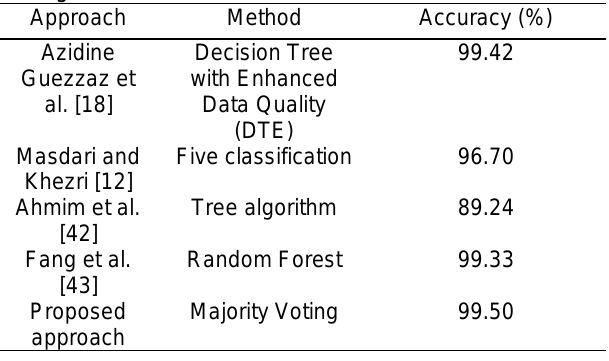
Table 12. Comparison of our approach using Majority Voting classifier with other works on NSL-KDD dataset